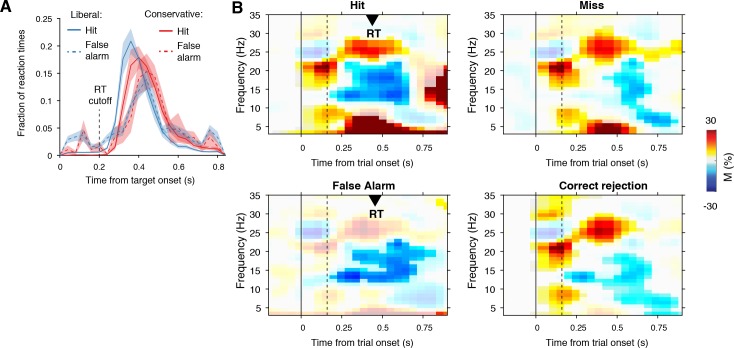
Behavioral and neurophysiological evidence that participants were sensitive to the implicit task structure.(A) Participant-average RT distributions for hits and false alarms in both conditions. The presence of similar RT distributions for false alarms and hits indicates that participants were sensitive to trial onset despite the fact that trial onsets were only implicitly signaled. Error bars, SEM. (B) Time-frequency representations of low-frequency EEG power modulations with respect to the pre-stimulus period (–0.4–0 s), pooled across the two conditions. Significant low-frequency modulation occurred even for nontarget trials without overt response (correct rejections), indicating that participants detected the onset of a trial even when neither a target was presented nor a response was given. Saturated colors indicate clusters of significant modulation, cluster threshold p<0.05, two-sided permutation test across participants, cluster- corrected; N = 15). Solid and dotted vertical lines respectively indicate the onset of the trial and the target stimulus. M, power modulation.